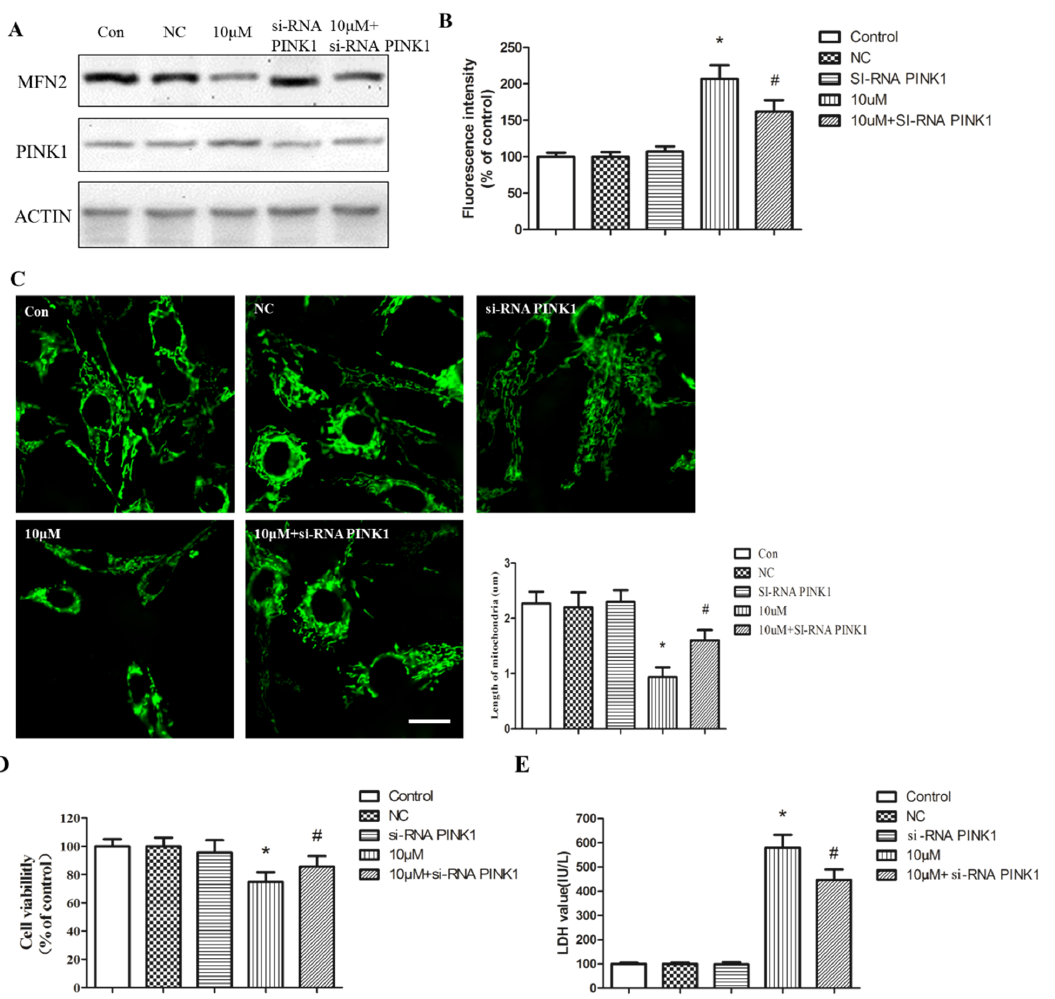
Figure 8. PINK1 underlies MFN2 downregulation after Pb exposure. After interference of PINK1, western blotting was performed to assess the expression of MFN2 ( A ). ROS generation was measured by DCFH-DA probe ( B ). Mitochondrial morphology in PC12 cells was observed using mito-tracker, which indicated the shrinkage of mitochondria after interference of PINK1 and Pb exposure. Quantitative measurement of mitochondrial length by NIS-Elements ( C ). The effect of Pb on cell viability was determined by MTT ( D ) and LDH ( E ) assay. The data are expressed as mean ± SD of three independent experiments. * p < 0.05 compared with control group; # p < 0.05 compared with Pb-treatment group.